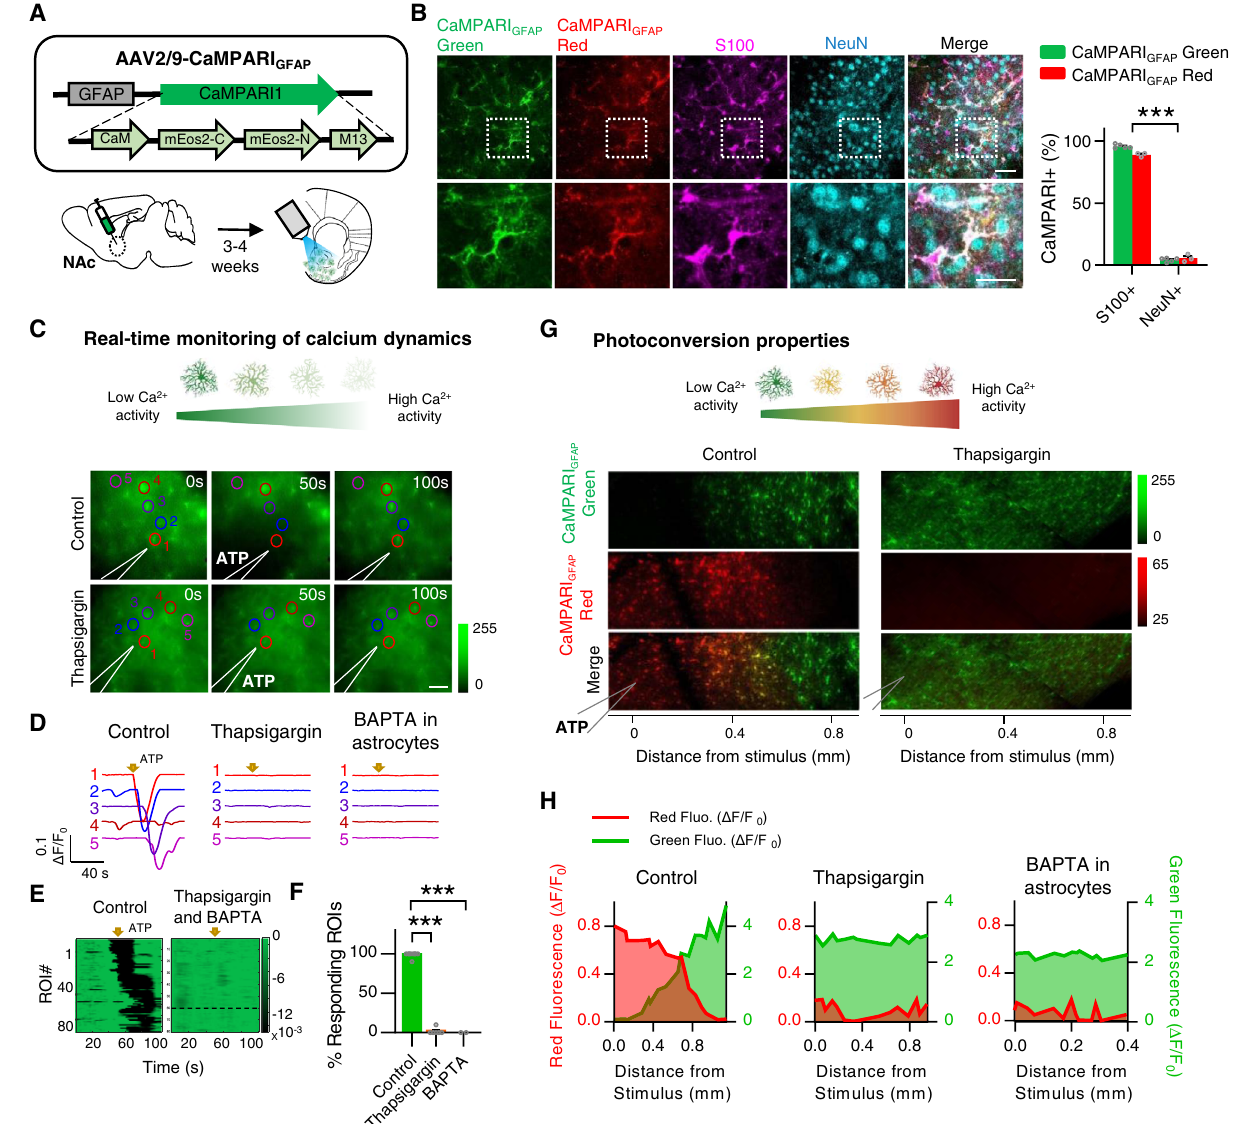
Fig. 1 | Development of CaMPARI GFAP as a functional tool to study astrocytic networks.A Top,CaMPARI1wasexpressedwithinanadeno-associatedvirus(AAV) vector system, under the glial fi brillary acidic protein (GFAP) astroglial promoter. Bottom, CaMPARI GFAP wasinjected in the nucleus accumbens (NAc) for acute slice imaging. B Left, confocal images of CaMPARI GFAP expression in NAc astrocytes. Fluorescence signals show green-to-red photoconversion after illumination with 405nm light. Magenta and cyan show inmunolabeling with astrocytic (S100) and neuronal (NeuN) markers (right; scale bar=100 µ m) and their inset (bottom; scale bar=30 µ m). Right, quanti fi cation showing S100 and NeuN cell populations with percentages of CaMPARI GFAP green- and red-positive cells (8 fi elds, 2 mice). Two- way ANOVA, *** P <0.001. C Top, scheme of CaMPARI GFAP green fl uorescence as a negative calcium indicator, when CaMPARI GFAP binds Ca 2+ its fl uorescence decreases.Bottom,time-lapseofastrocyticactivitymonitoringCaMPARI GFAP green fl uorescencechangesinacuteslicesrespondingtoATP(20mM)stimulusincontrol condition and after perfusion ofthapsigargin (1 µ M). Scale bar,50 µ m. D Astrocytic